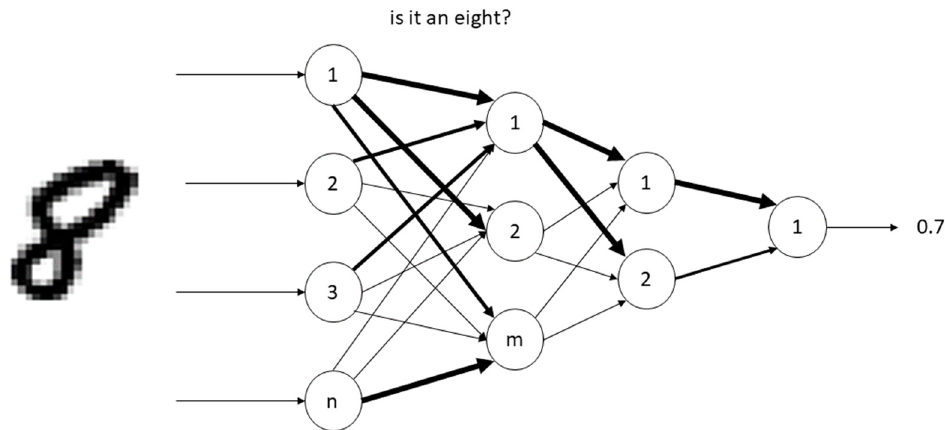
Figure A5. Inputs and weights of an artificial neural network for the identification of a number; the thick lines represent the weights with the greatest influence on forming a conclusion.